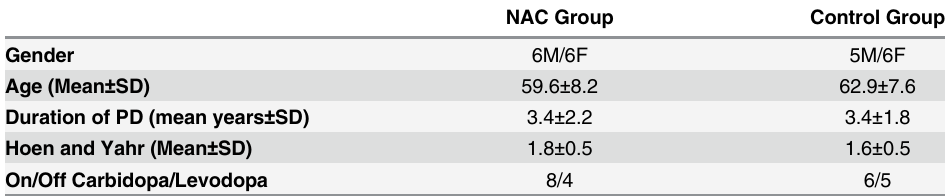
Table 1. Demographics for the study subjects per